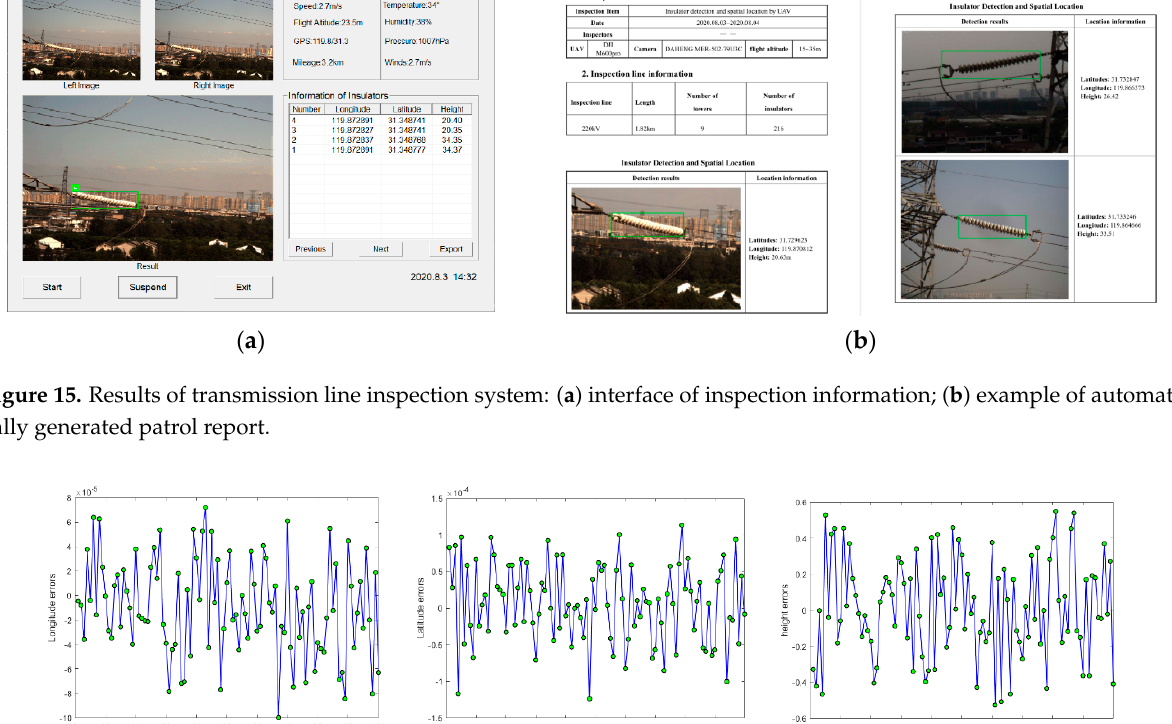
Figure 15. Results of transmission line inspection system: ( a ) interface of inspection information; ( b ) example of automat- ically generated patrol report.